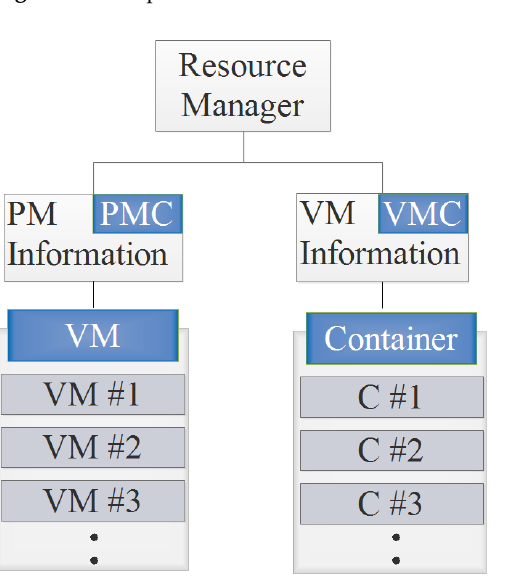
Figure 5. Example of Container Placement.